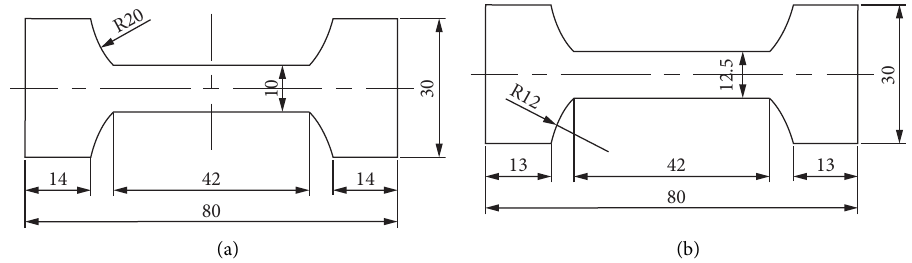
Figure 8: Dimensions of tensile specimens. (a) Thickness less than 3 mm. (b) Thickness greater than 3mm.